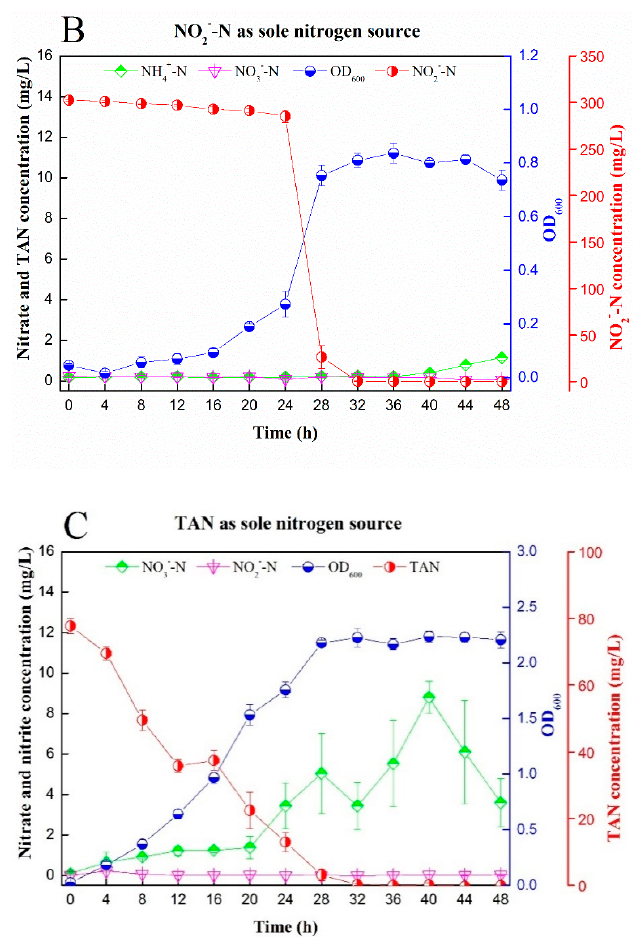
Figure 2. Aerobic nitrogen-removal ability and cell growth of the strain RAD-17 in denitrification media (DM) and heterotrophic nitrification media (HNM) mediums. ( A ) Nitrate as the sole nitrogen source; ( B ) nitrite as the sole nitrogen source; ( C ) ammonium as the sole nitrogen. Date shown are means ± SD (error bars) from three replicates.